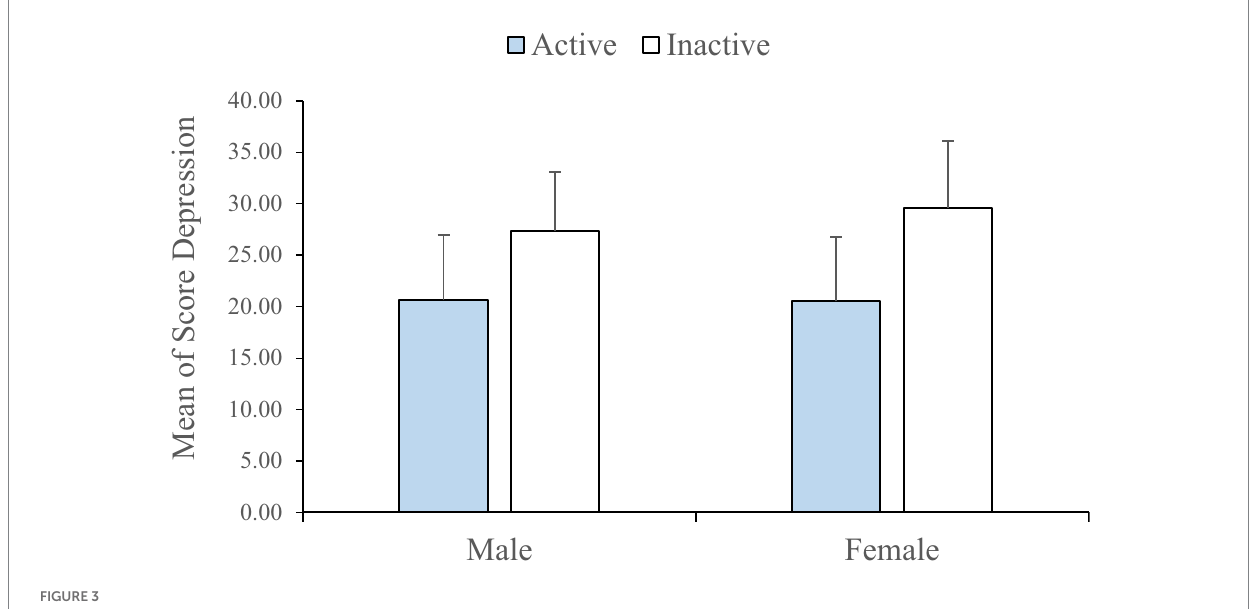
FIGURE 3 Mean depression scores in two active and inactive groups based on gender.